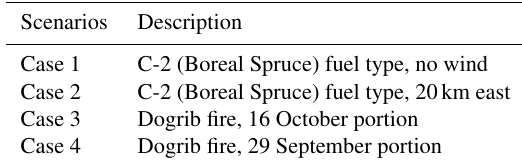
Figure 2. The two base scenarios.